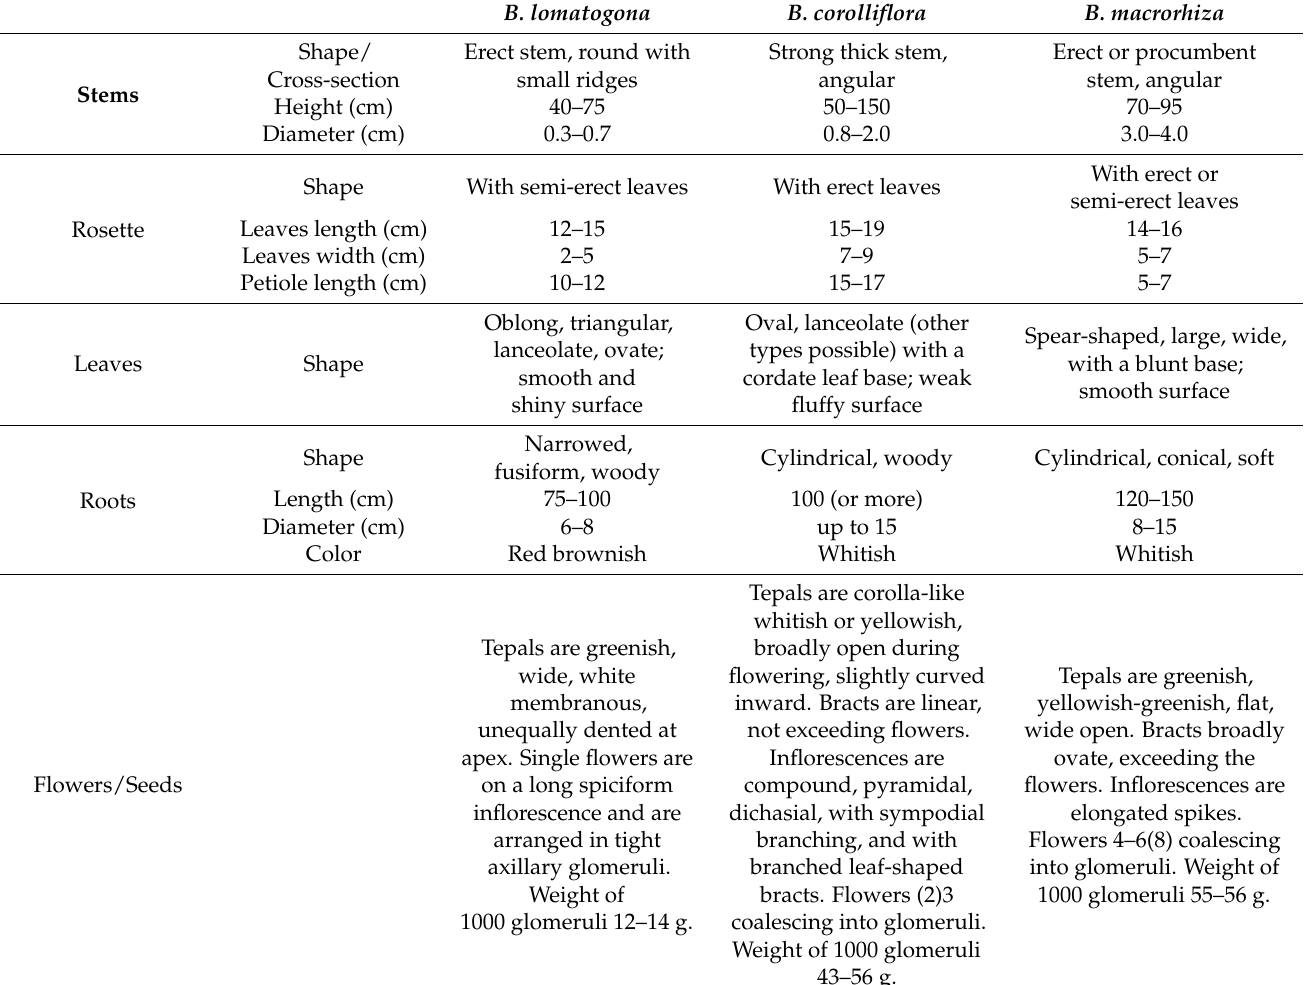
Table 3. Morphological features of the wild beet species in